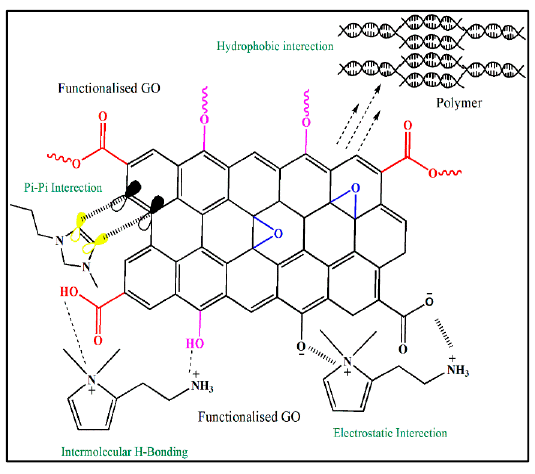
Figure 2. Non-covalent functionalization of